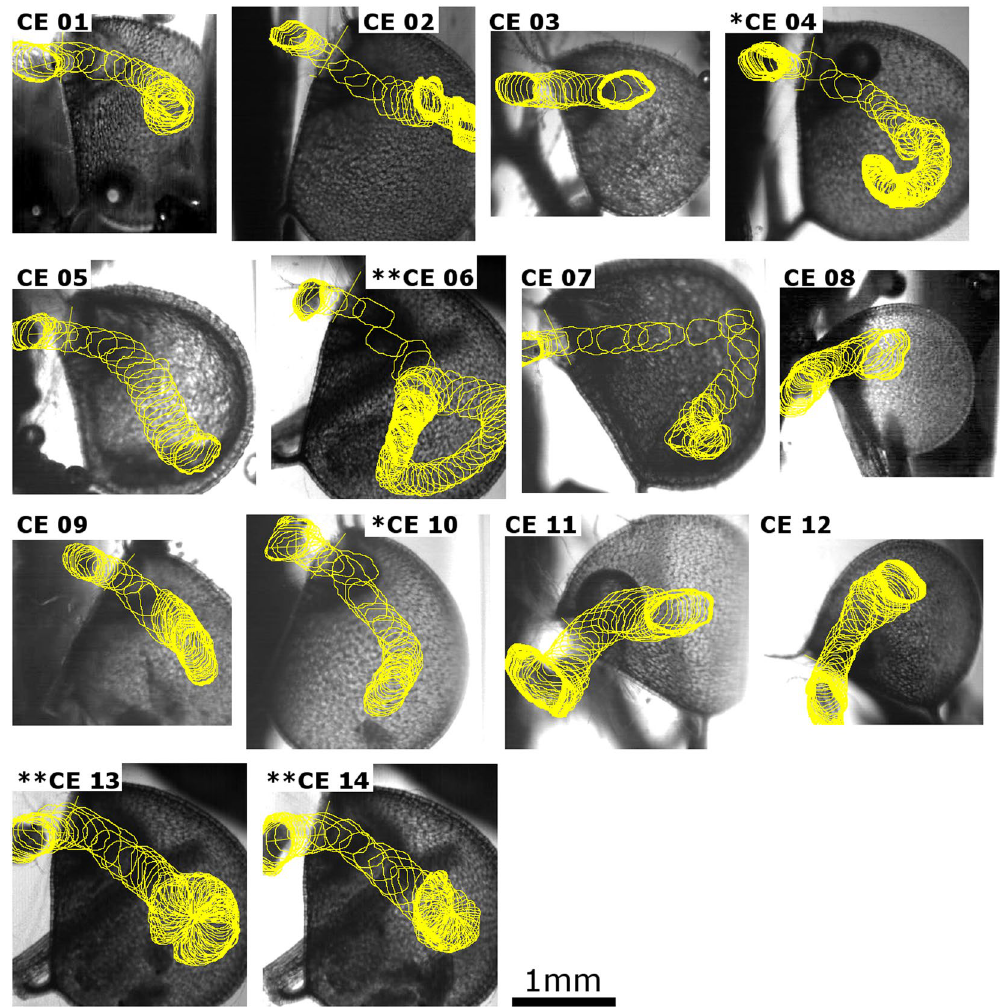
Figure 2. High-speed analyses of Ceriodaphnia dubia capture events (CEs) by Utricularia australis . The trap entrances face left, and the contours of the prey animals during the CEs are retraced (the time intervals between two frames is 0.1 ms). The prey animals in CEs 06, 07, 13 & 14 loop within the respective traps. CEs marked by a single asterisk ( * CEs 04, 10) or with a double asterisk ( ** CEs 06, 13, 14) were recorded in the same traps, respectively. Brightness and contrast were adjusted for image